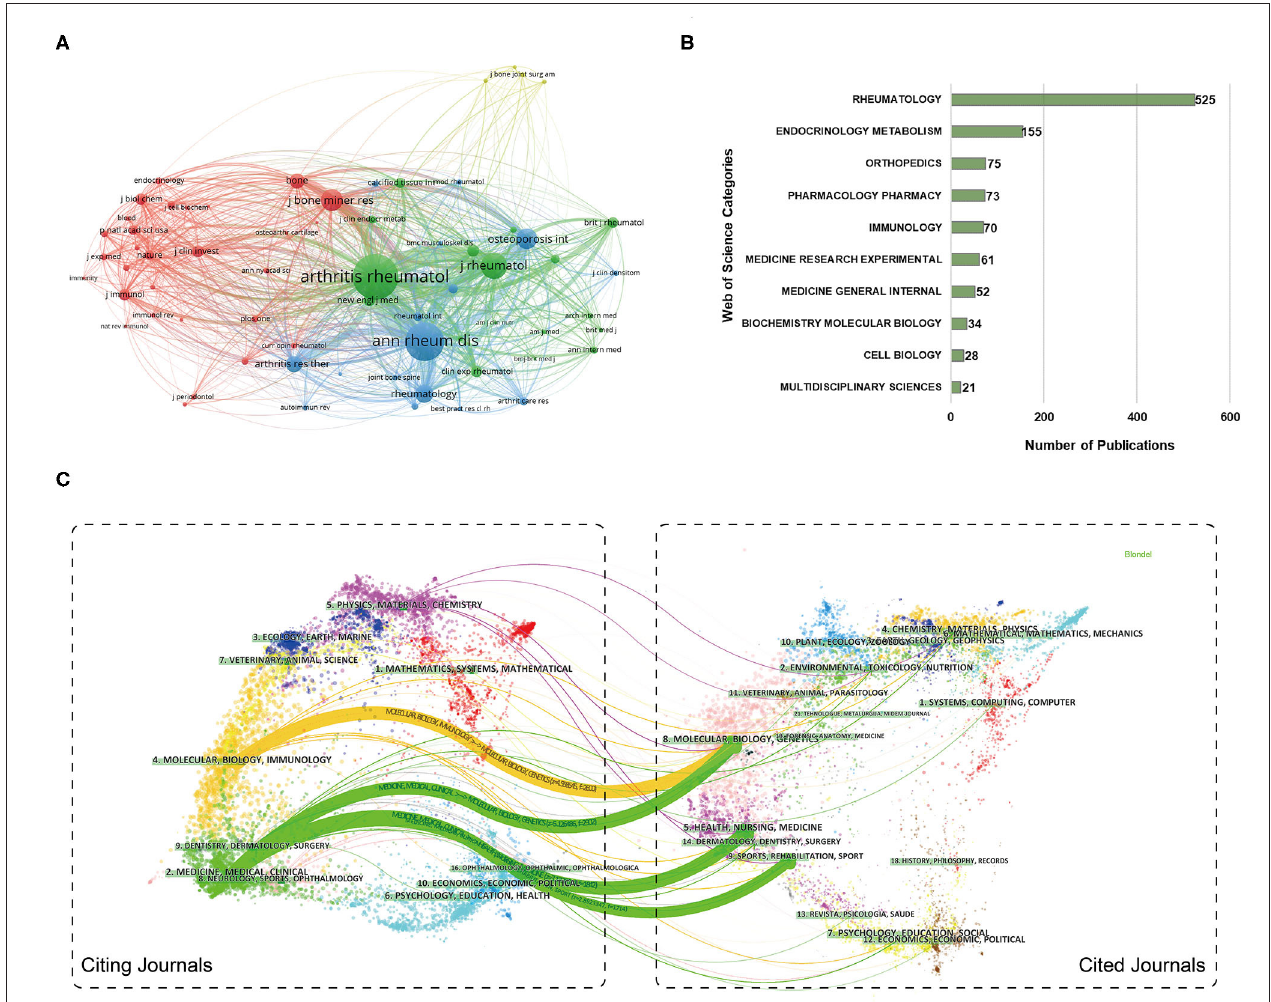
FIGURE 5 | (A) Network visualization map of journal co-citation analysis based on VOSviewer software. (B) The top 10 most relevant WoS subject categories. (C) The dual-map overlay of academic journals in the field of ORA research (generated by CiteSpace software).